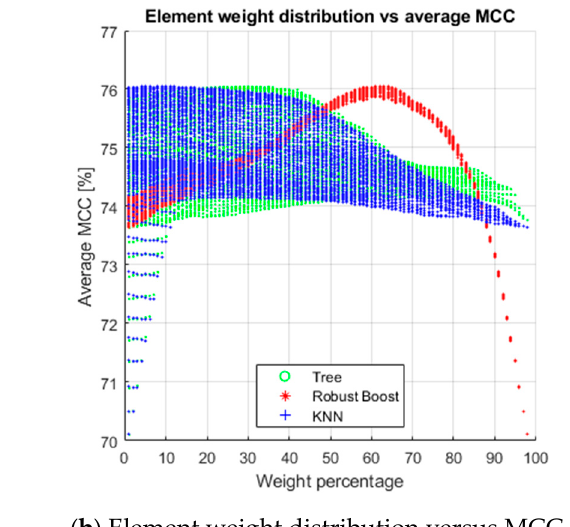
Table 9. The performance results of the individual models.